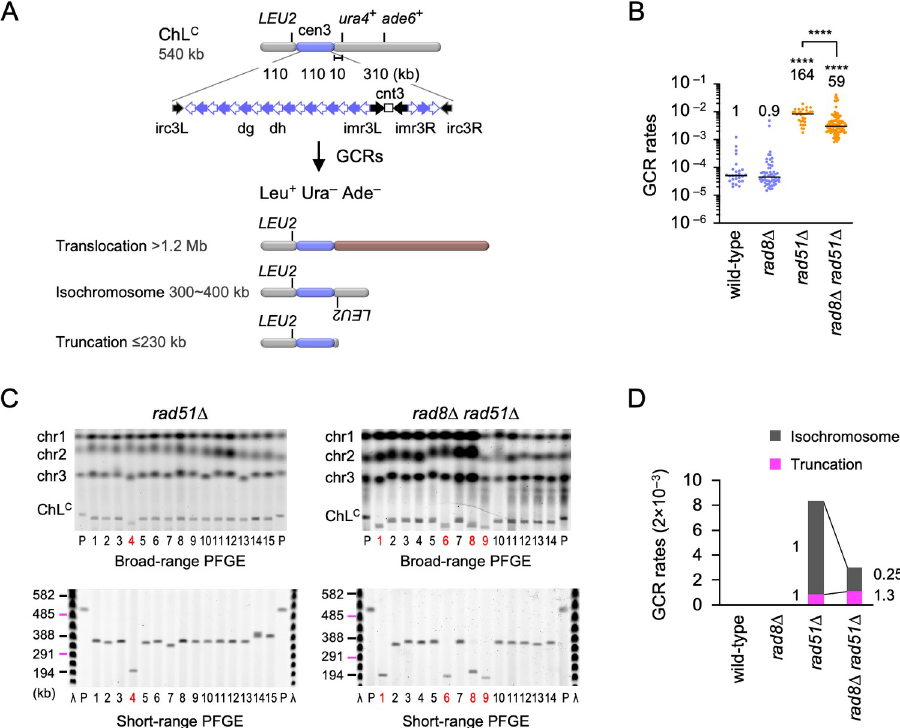
Fig 1. Fission yeast Rad8 facilitates isochromosome formation. (A) The ChL C chromosome contains an entire region of centromere 3 (cen3) and three genetic markers: LEU2 , ura4 + , and ade6 + . Gross chromosomal rearrangements (GCRs) associated with loss of both ura4 + and ade6 + result in the formation of Leu + Ura − Ade − cells. The structure and the length of three GCR types: translocation, isochromosome, and truncation are shown. (B) GCR rates of the wild-type, rad8 Δ , rad51 Δ , and rad8 Δ rad51 Δ strains (TNF5369, 5549, 5411, and 5644, respectively). Each dot represents an independent experimental value obtained from an independent colony. Black bars indicate medians. Rates relative to that of wild type are shown on the top of each cluster of dots. Statistical analyses between the wild-type and mutant strains, and that between rad51 Δ and rad8 Δ rad51 Δ strains were performed by the two-tailed Mann- Whitney test. ���� P < 0.0001. (C) Chromosomal DNAs prepared from the parental (P) and independent GCR clones of rad51 Δ and rad8 Δ rad51 Δ strains were separated by broad- and short-range PFGE (top and bottom rows, respectively). Positions of chr1, chr2, chr3, and ChL C (5.7, 4.6, ~3.5, and 0.5 Mb, respectively) are indicated on the left of broad-range PFGE panels. Sizes of Lambda ( λ ) ladders (ProMega-Markers, Madison, Wisconsin, G3011) are displayed on the left of short-range PFGE panels. Sample number of truncations are highlighted in red. (D) Rates of each GCR type. Rates relative to those of rad51 Δ are indicated. Numerical source data underlying the graphs shown in (B) and (D) are provided respectively in Tables A and B in S1 File.